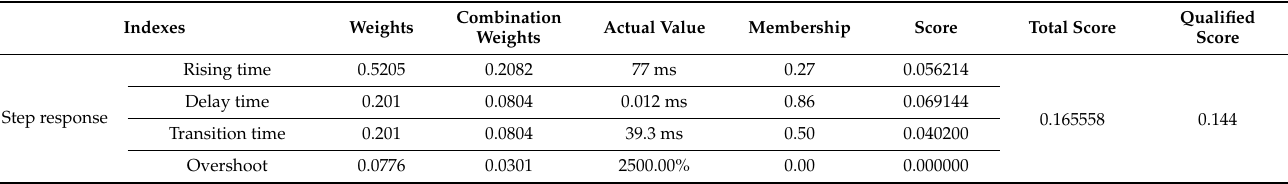
Table A3. PID controller torque evaluation